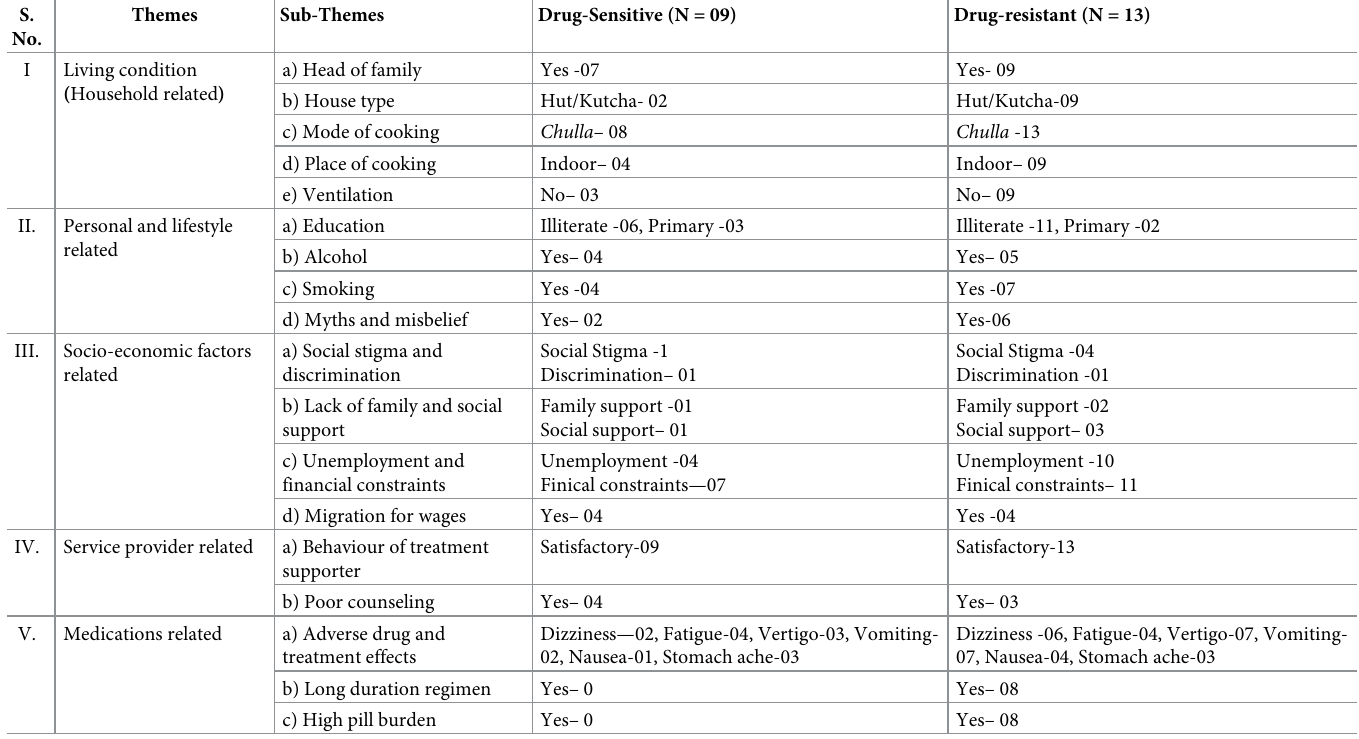
Table 2. Common themes that emerged during in-depth interviews of LTFU TB patients. S.